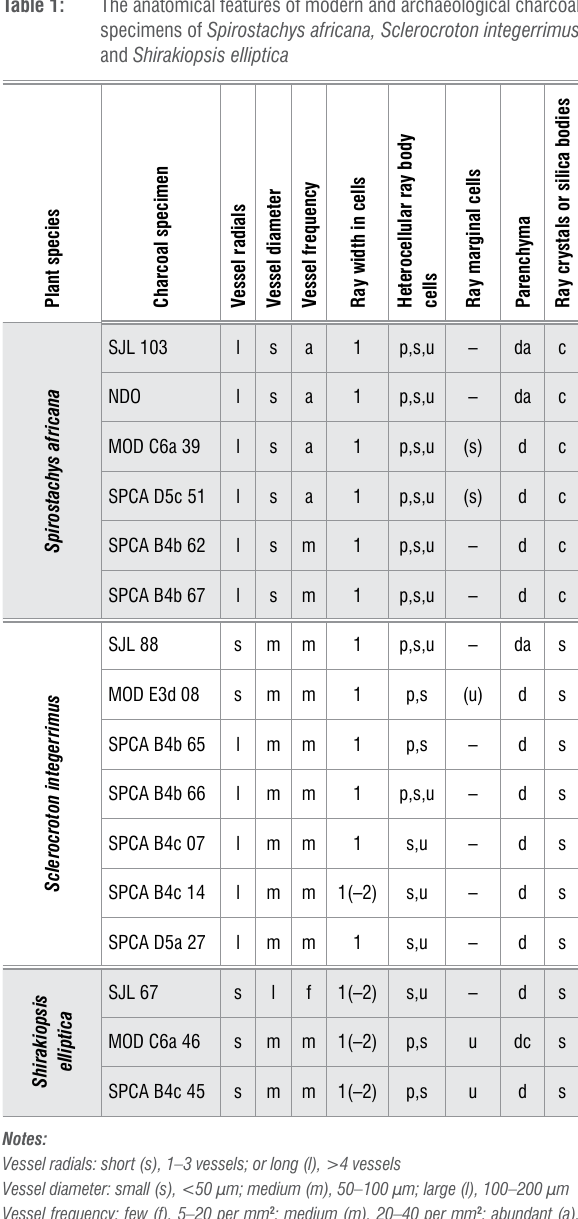
Attributes common to Spirostachys , Sclerocroton and Shirakiopsis Vessels are commonly arranged in long, radial multiples (>4).